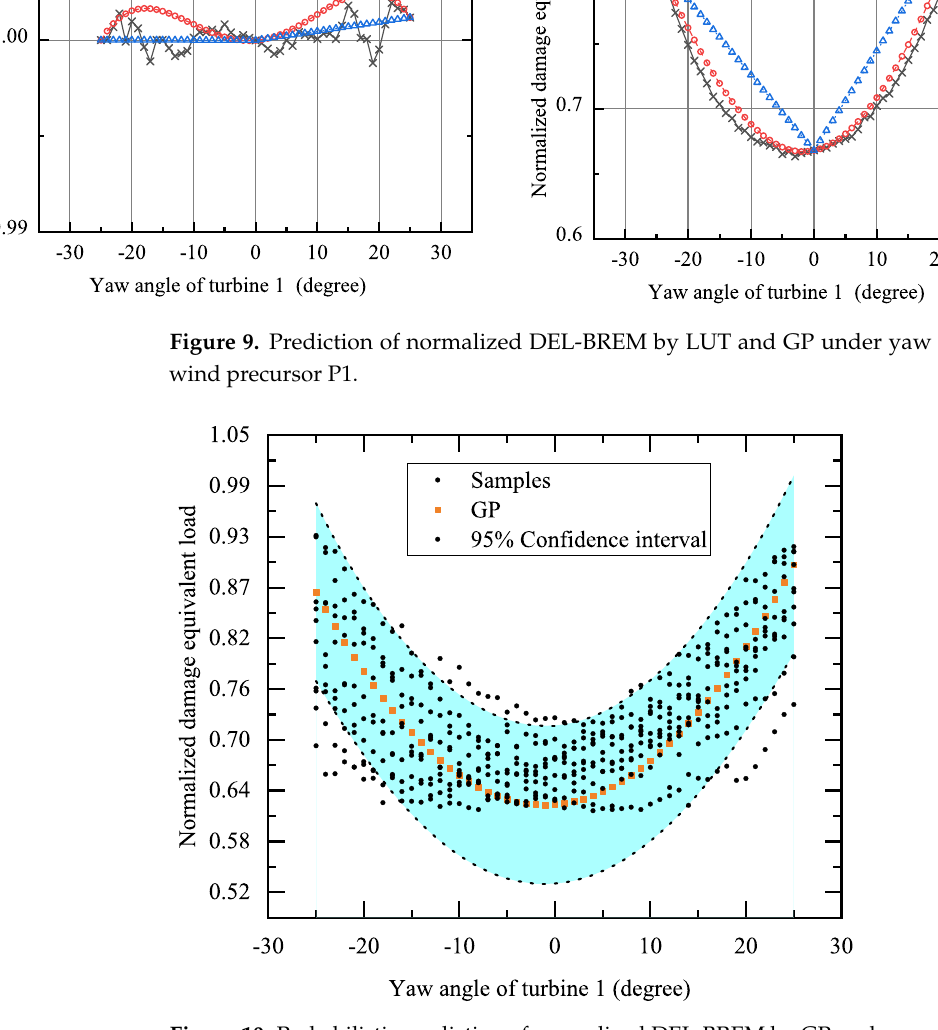
Figure 10. Probabilistic prediction of normalized DEL-BREM by GP under yaw control mode Y1 and wind precursor